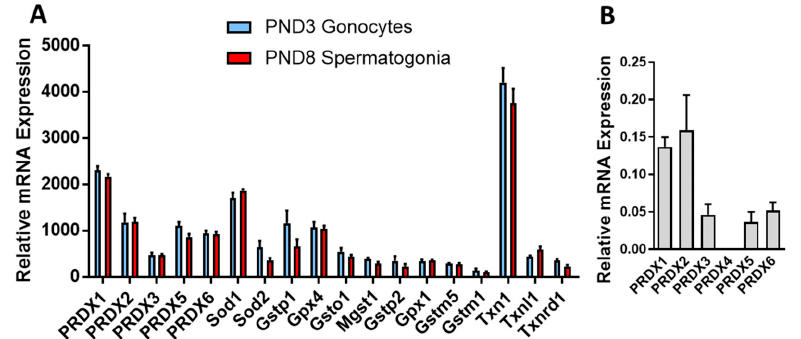
spermatogonia. ( A ) gene array analysis of PND3 gonocytes and PND8 spermatogonia antioxidant genes. ( B ) qPCR analysis of PRDXs expression in PND3 gonocytes. Results represent the means ±